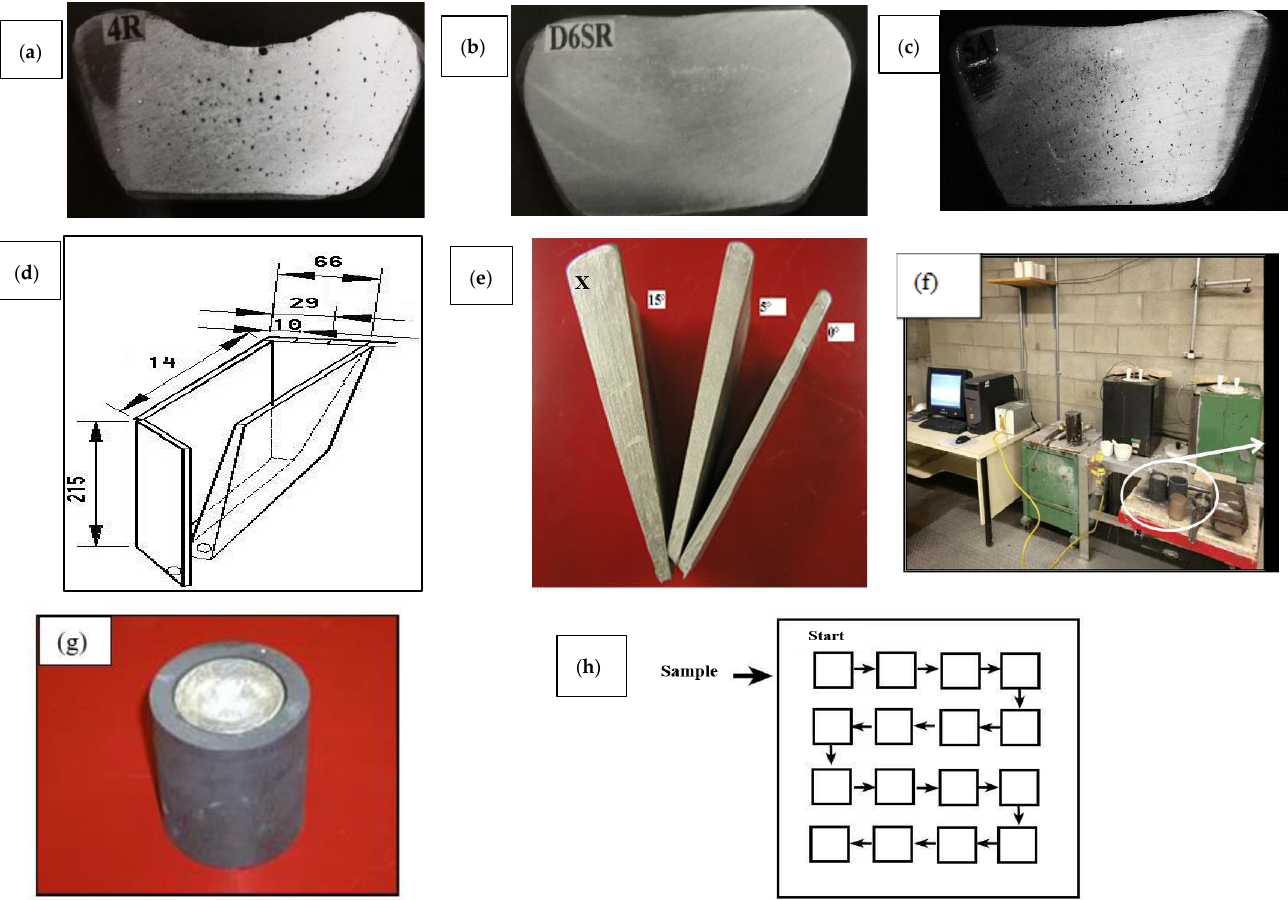
Figure 1. Examples of RPT test samples obtained from Al–Si–Cu (Mg) alloy melts: ( a ) before degassing, ( b ) 0.1 mL/100 g Al, ( c ) 0.3 mL/100 g Al. ( d ) Schematic diagram of the variable angle wedge mold and the position of used thermocouples; ( e ) Variable angle mold castings. All dimensions are in mm. ( f ) Slow cooling rate casting set-up, with smaller electrical resistance furnace, and ( g ) cylindrical graphite mold used for casting. ( h ) Schematic diagram showing the sequence of measuring porosity—each square represents one